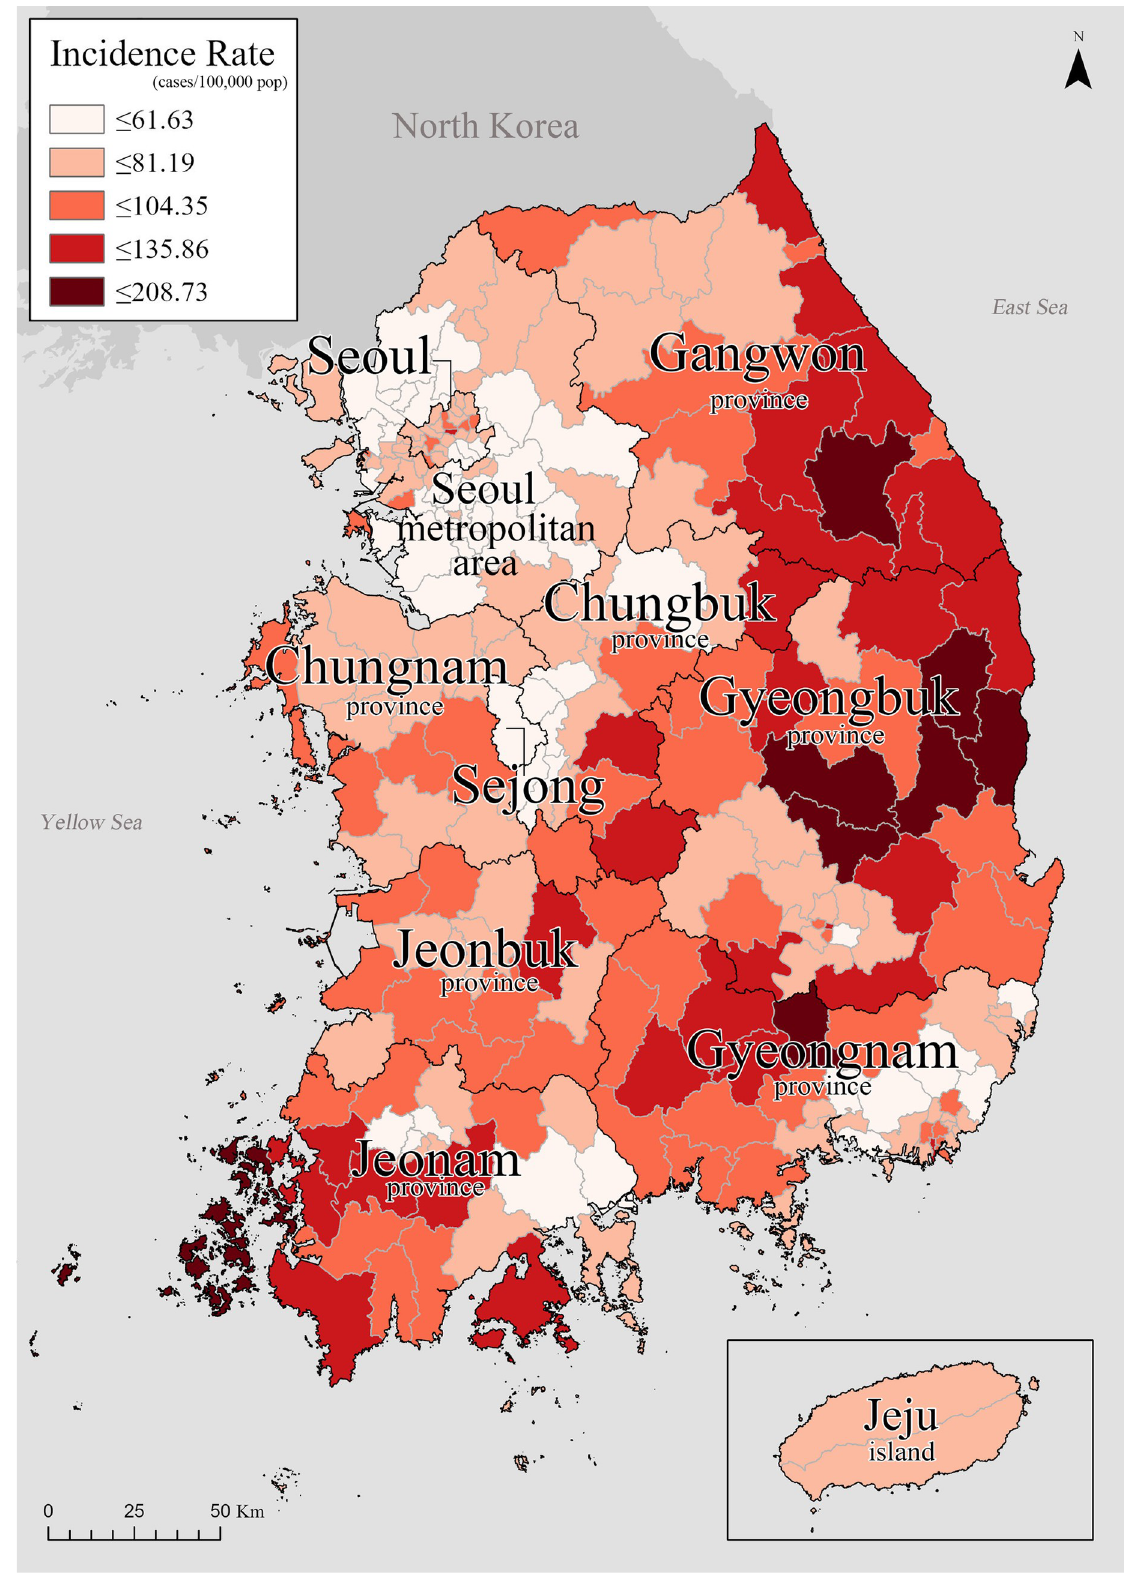
Fig 1. Study area and TB incidence rate (cases/100,000). https://doi.org/10.1371/journal.pone.0255727.g001 PLOS ONE | https://doi.org/10.1371/journal.pone.0255727 August 5,